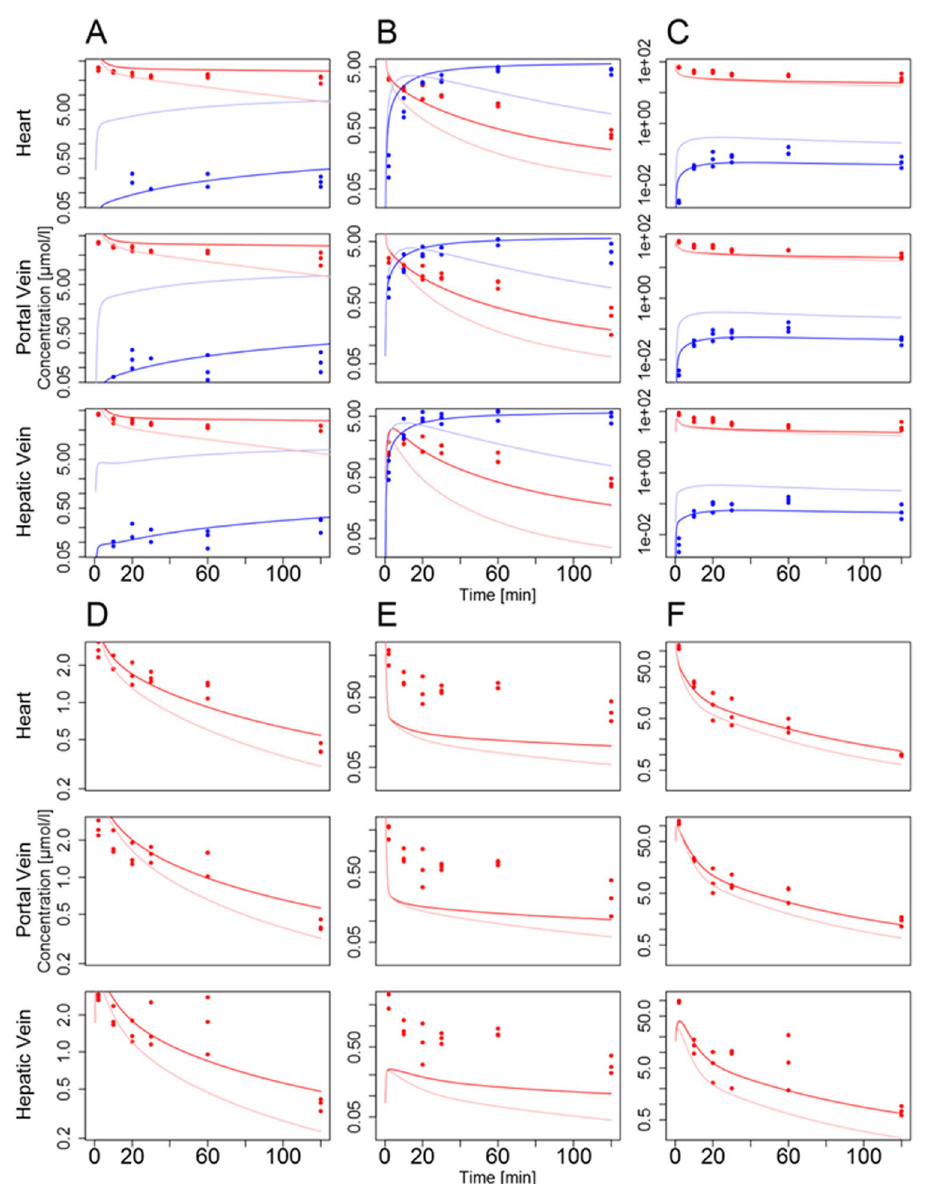
Figure 5. Simulated plasma concentration profiles (lines) for intoxicated mice and the corresponding experimental data (day one after CCl 4 administration, points) (red: parent drug; blue: metabolite), as well as the simulation of the healthy case (light red and light blue). The models for the damaged case were established by reducing the overall concentration of ADME-associated enzymes and transporters within the liver PBPK models. Simulations are shown for caffeine and paraxanthine ( A ), midazolam and 1 ′ -hydroxymidazolam ( B ), torsemide and hydroxytorsemide ( C ), codeine ( D ), talinolol ( E ), pravastatin ( F